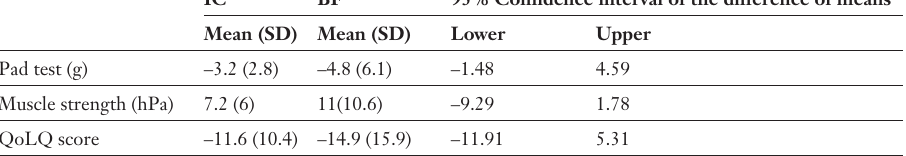
Comparison of pre and post treatment differences in pad test, pelvic floor mus- cle strength and qual- ity of life question- naire values between groups (t-test for in- dependent